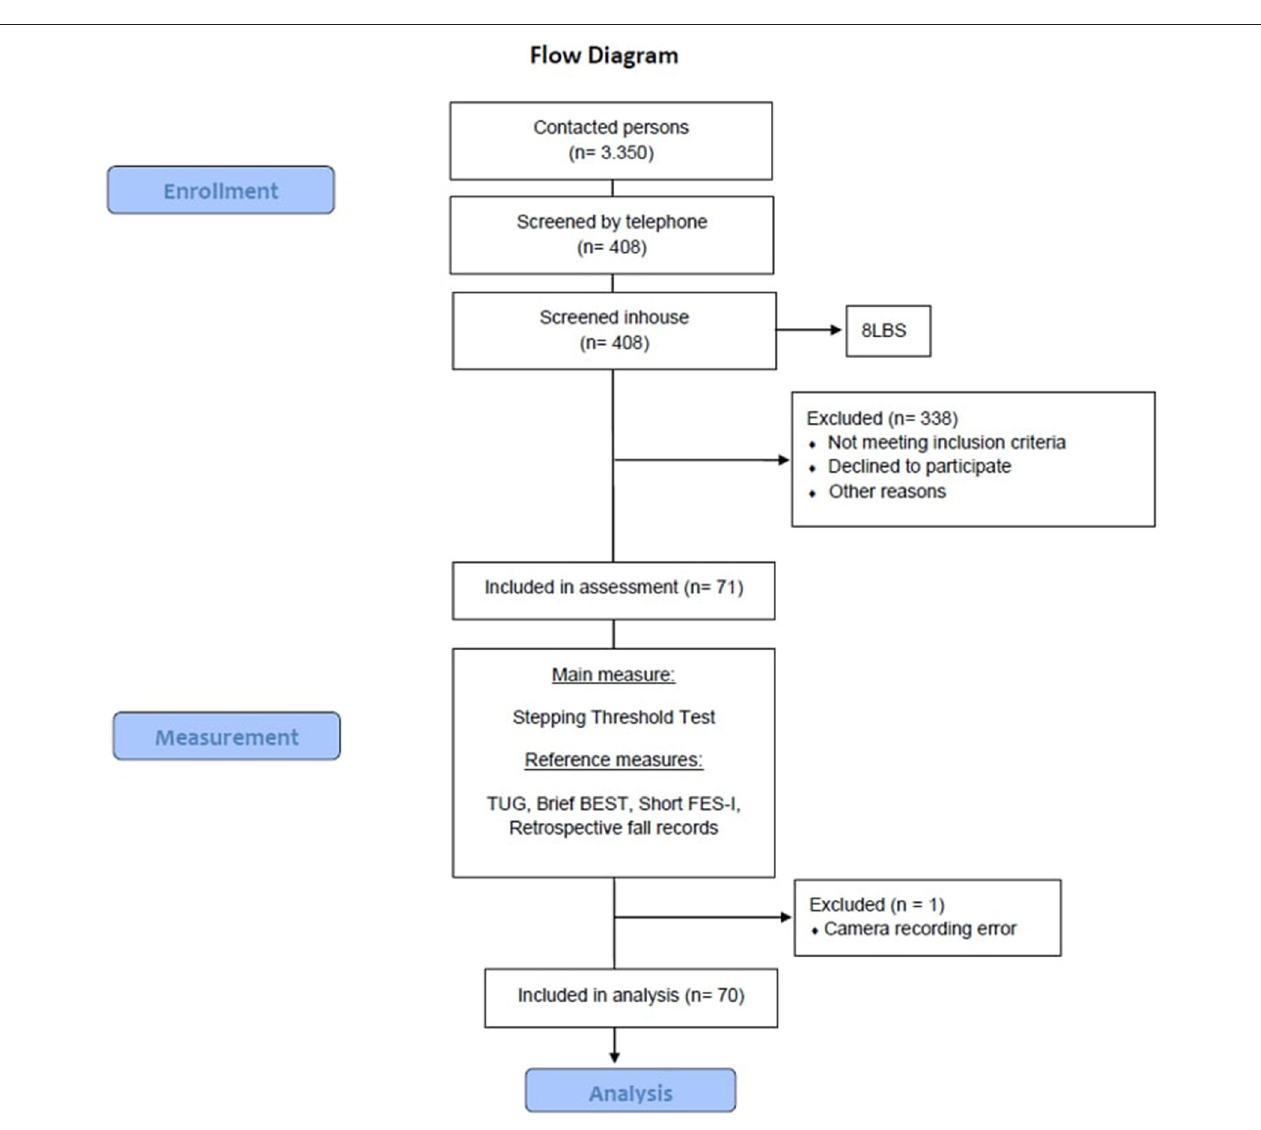
FIGURE 1 | The course of study. BriefBEST, Brief Balance Evaluations Systems Test; FES-I, Short Falls Efficacy Scale—International; TUG, Timed Up and Go Test; 8LBS, Eight level balance